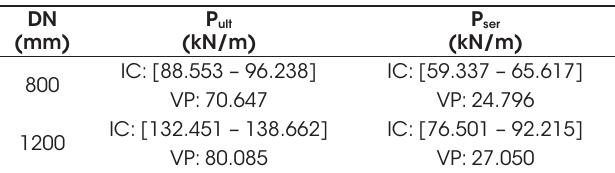
Confidence intervals (CI) for 95% of confidence and design values (DV) of P in the reinforced concrete pipes calculated